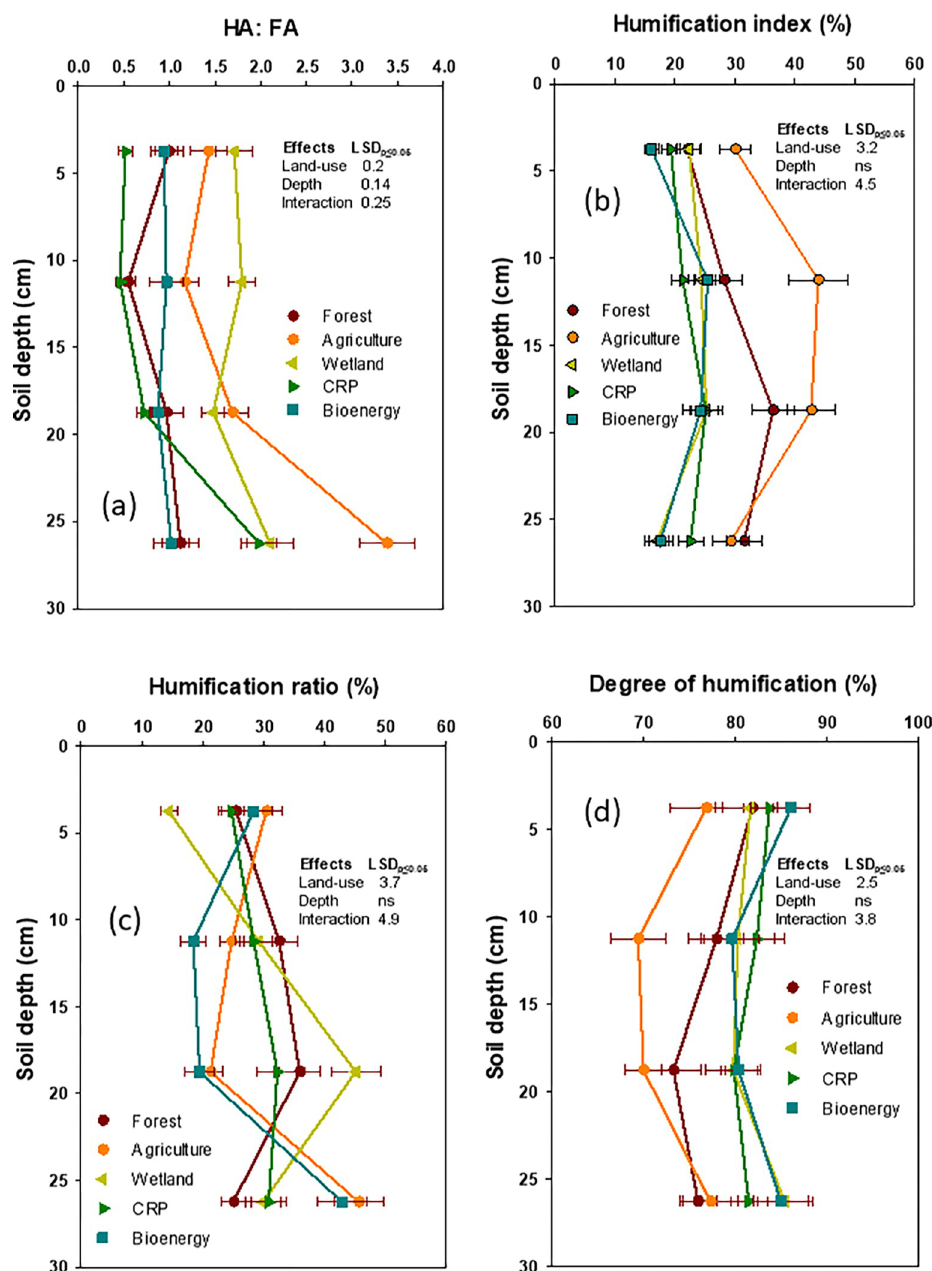
Fig 3. Impact of deforestation and subsequent land-use diversity on humic acid (HA) and fulvic acid (FA) distribution and humification characteristics of organic carbon at different soil depths (data were presented with mean ± standard